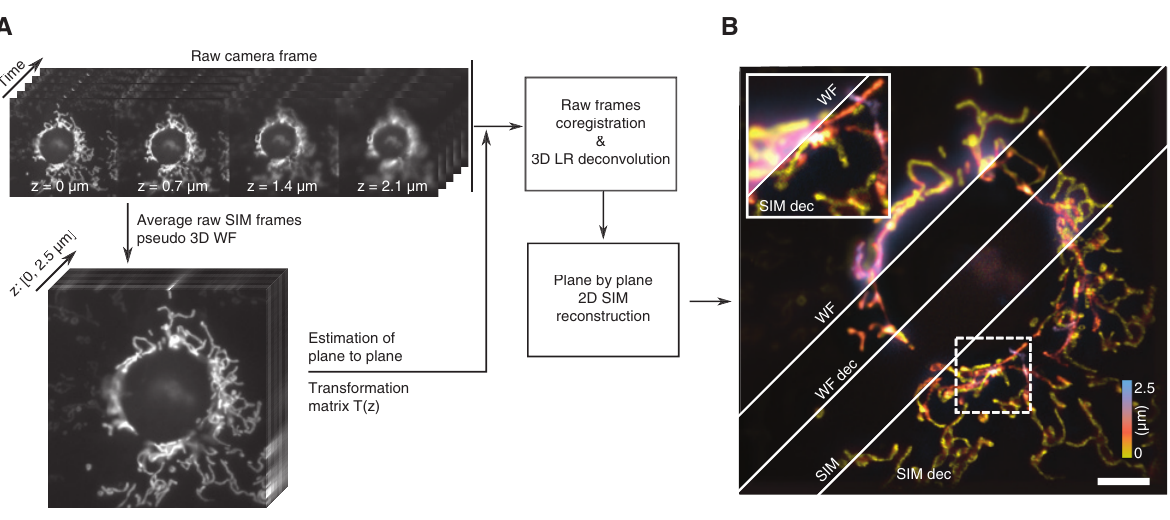
Figure 2: Data processing and SIM image reconstruction procedure. (A) The raw images are first averaged to produce a pseudo wide-field image. This image is then used to estimate the interplane transformation matrix T ( z ). This matrix is used to coregister the raw SIM images and reorder the data in x , y , z , t space. Then, the data are either averaged (WF), deconvolved in 3D (WF dec), reconstructed (SIM), or deconvolved and reconstructed (SIM dec). (B) Colour-coded maximum intensity z -projection of 3D images for all four modalities on a fixed COS-7 cells labelled with MitoTracker Orange. Inset shows a zoomed in comparison between WF and deconvolved SIM. Scale bar 5 μ m.